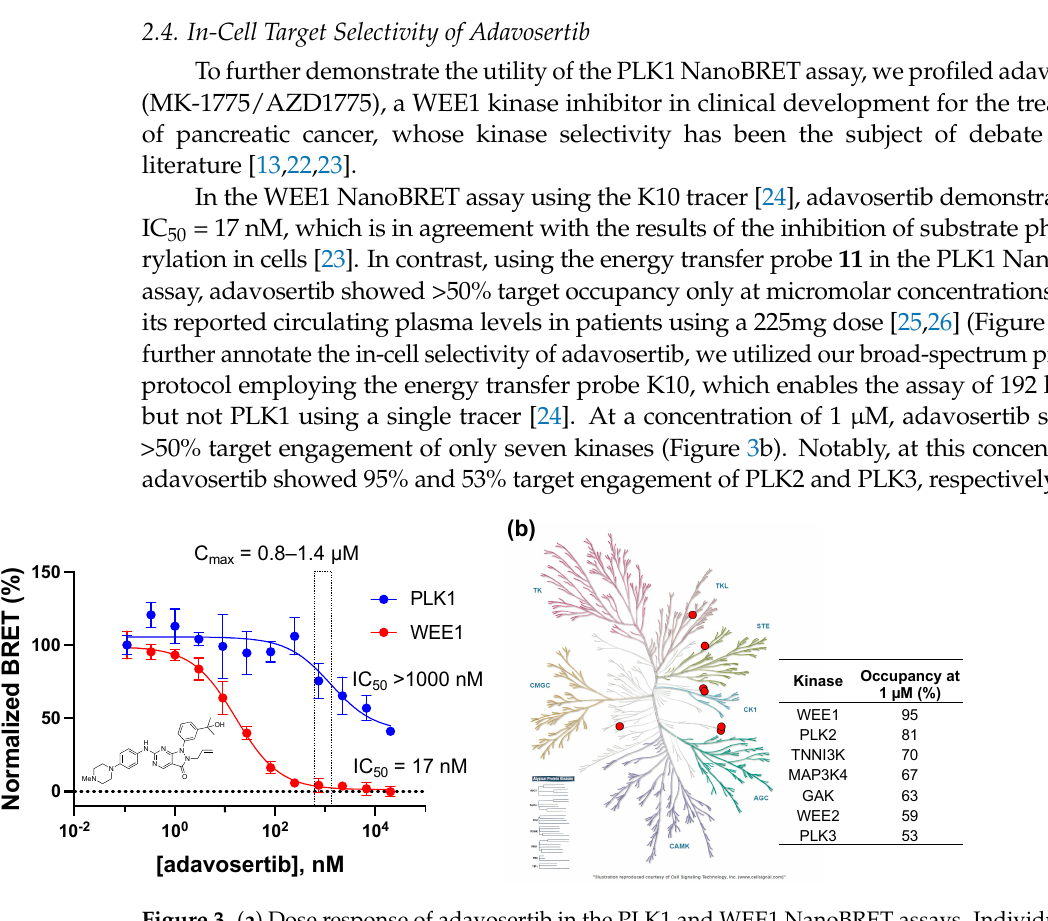
Figure 3. ( a ) Dose response of adavosertib in the PLK1 and WEE1 NanoBRET assays. Individual data points are the mean ± SE of at least three technical replicates. The light yellow shaded box shows the range of median C max of 225 mg adavosertib. ( b ) Live cell target occupancy of adavosertib at 1 μ M across 192 kinase NanoBRET assays using the K10 tracer [24]. Only 7 kinases showed >50% occupancy, shown as the red dots on a kinome tree generated by KinMap (http://www.kinhub.org/kinmap/, accessed on 1 March 2023) with the % occupancy noted.